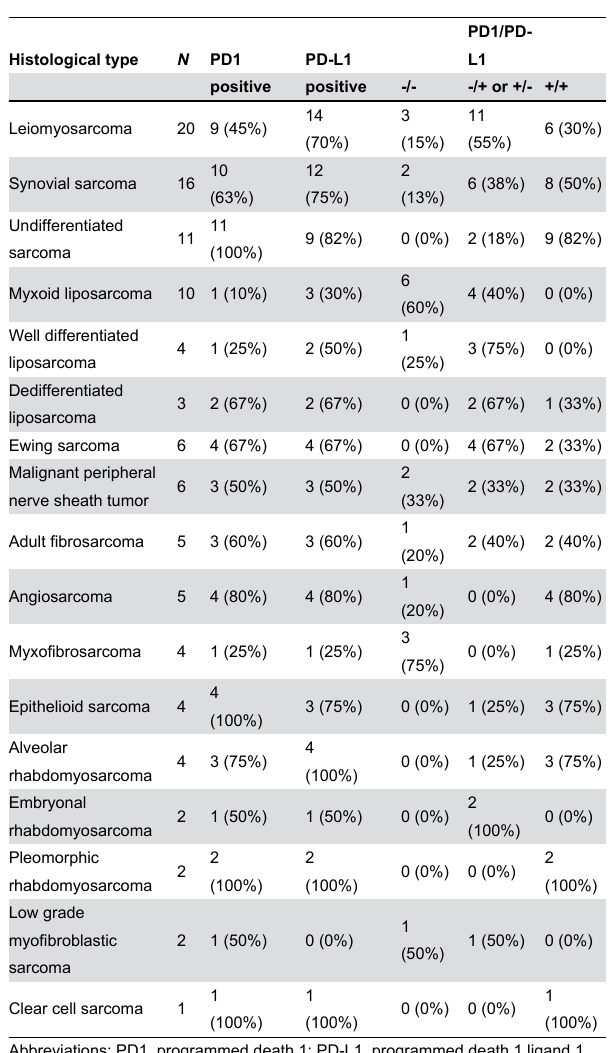
Table 1. The expression status of PD1 and PD-L1 according to the histological type of soft-tissue